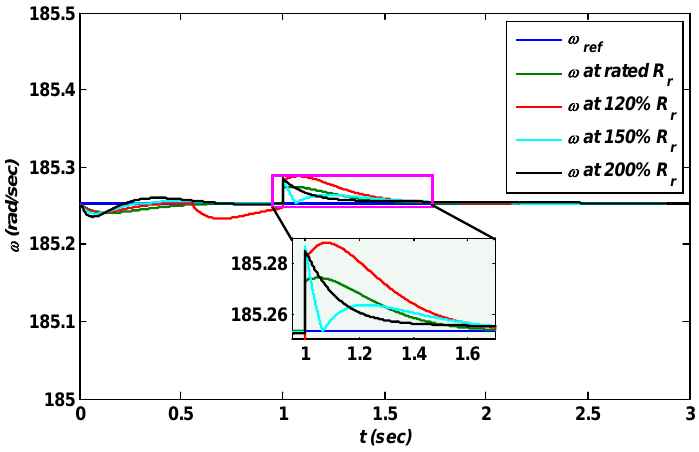
Figure 16. Speed control of IFOC IM using Hybrid Control (HC).